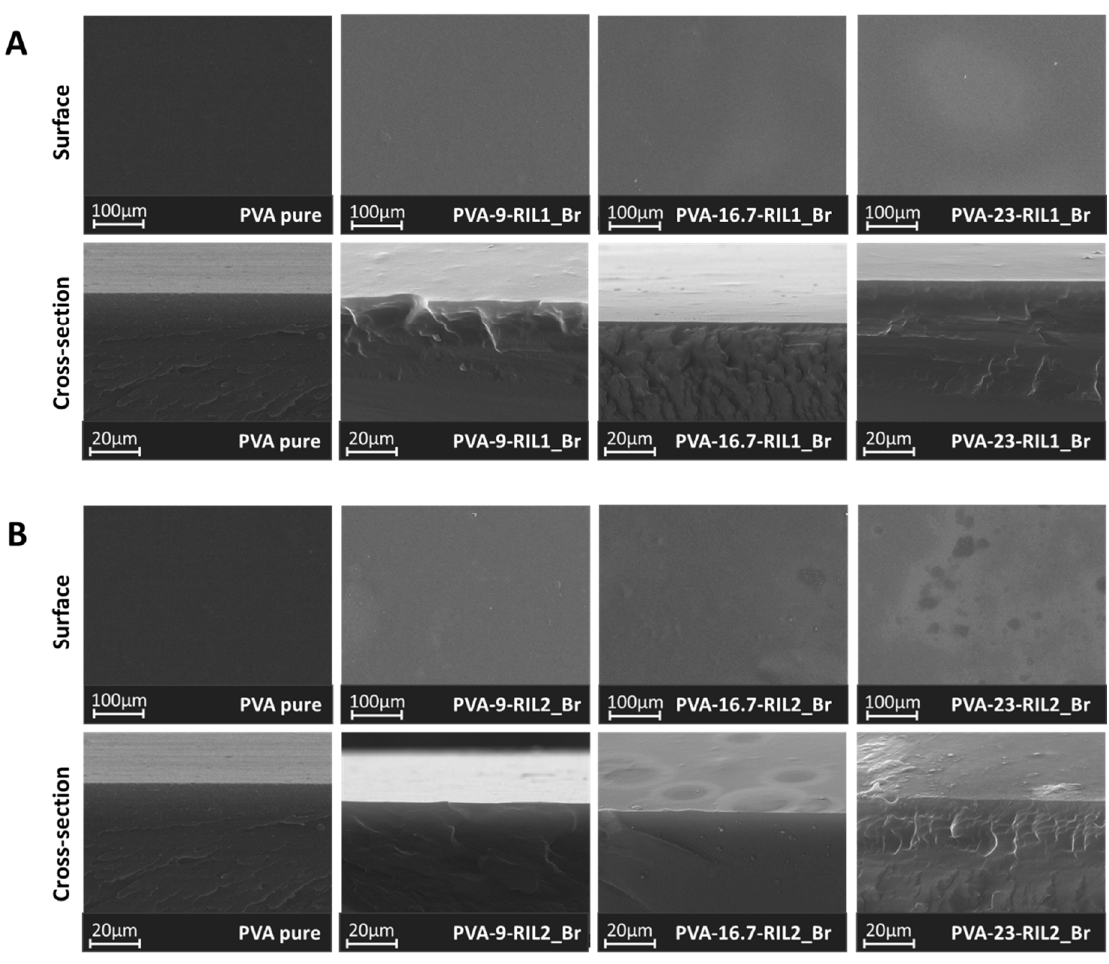
Figure 10. SEM images of ( A ) PVA-RIL1_Br and ( B ) PVA-RIL2_Br membranes surface and cross- section.